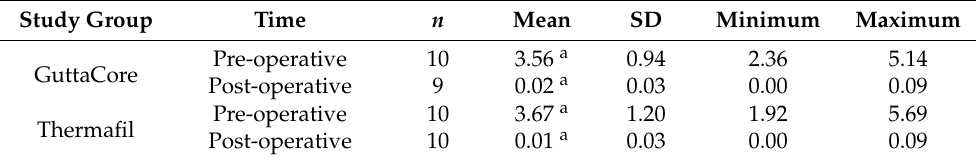
Table 2. Descriptive analysis of the pre-operative root canal filling material volume (mm 3 ) and the remaining post-operative root canal filling material volume (mm 3 ) at the middle third of the root canal systems.